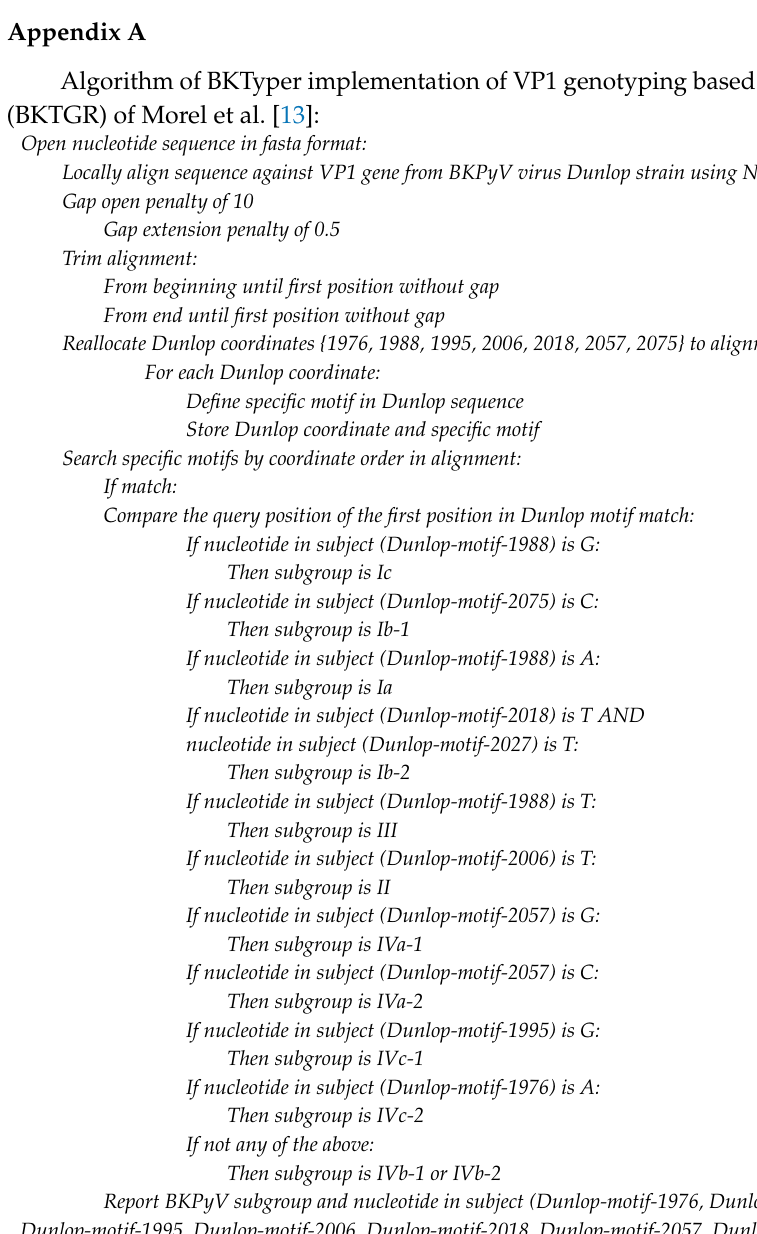
Algorithm of BKTyper implementation of VP1 genotyping based on BK typing and grouping regions (BKTGR) of Morel et al. [13]: Open nucleotide sequence in fasta format: